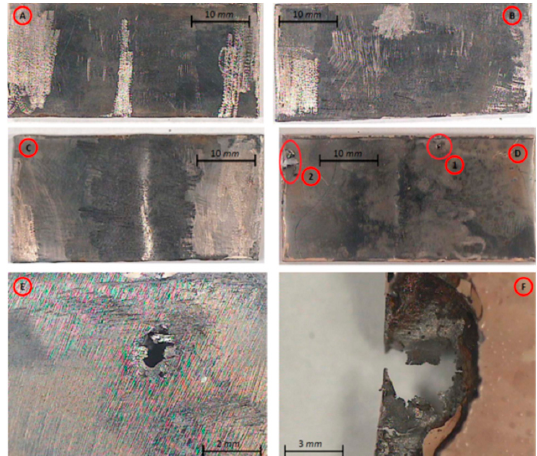
Figure 4. Pitting corrosion test of 304 stainless steel with 316L filler specimens welded in conventional atmosphere: ( A ) not-irradiated condition; ( B ) exposed to 200 Gy; ( C ) to 700 Gy; ( D ) to 1000 Gy; (E) defect 1 amplification from ( D ); (F) defect 2 amplification from ( D ).